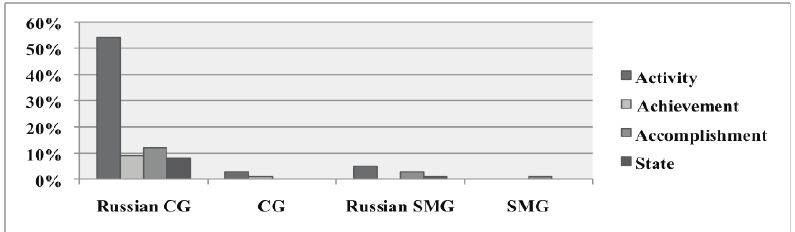
Figure 8: Non-target production: embedded verbs